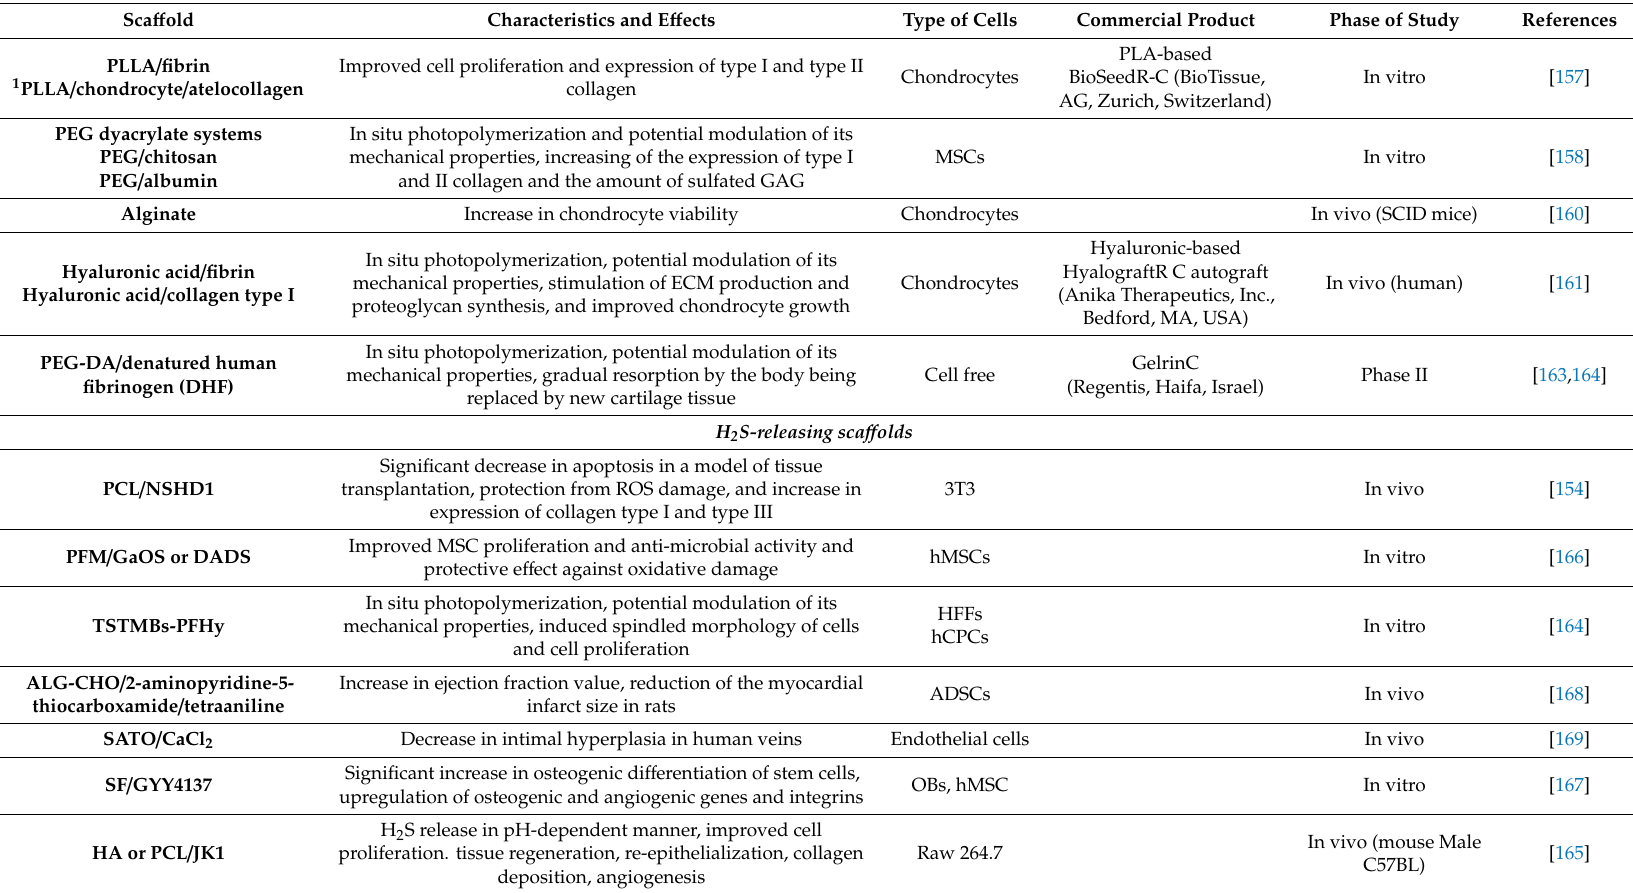
Table 2. Sca ff olds and H 2 S-releasing sca ff olds for potential applications in the therapy of